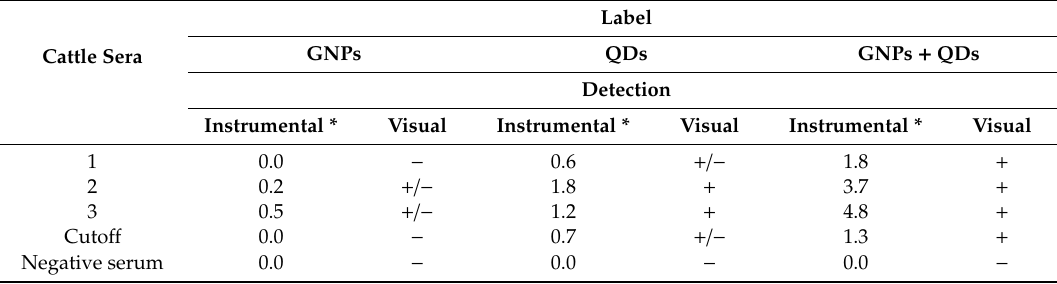
Table 1. Results of digitization of images of test systems for immunochromatographic serodiagnostics of cattle brucellosis.